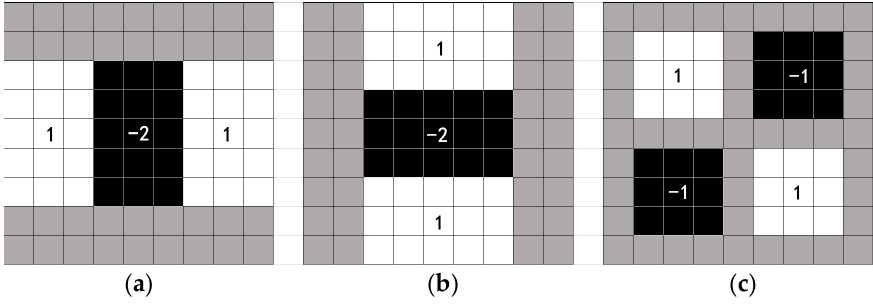
Figure 2. Approximations using box fi lters. ( a ) x direction. ( b ) y direction. ( c ) xy direction.